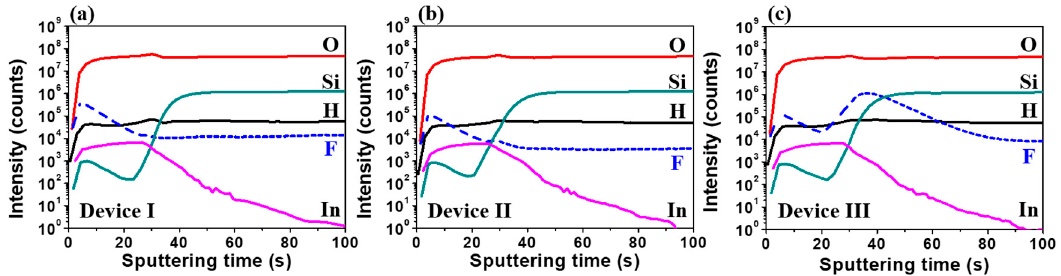
Figure 3. The dynamic secondary-ion mass spectroscopy (D-SIMS) profiles of H, O, F, Si and In for devices ( a ) I, ( b ) II and ( c ) III, respectively.